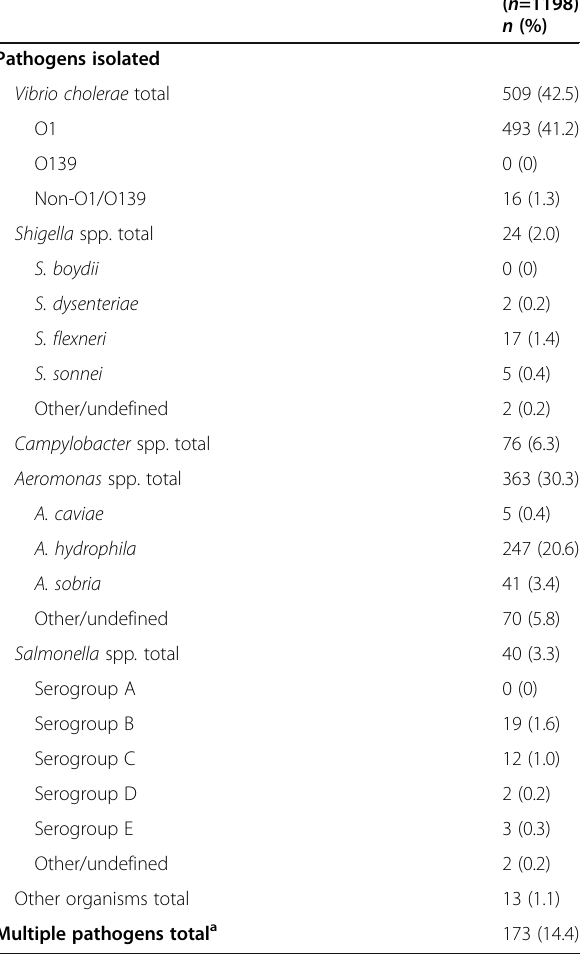
Table 1 Prevalence of enteric pathogens isolated from stool